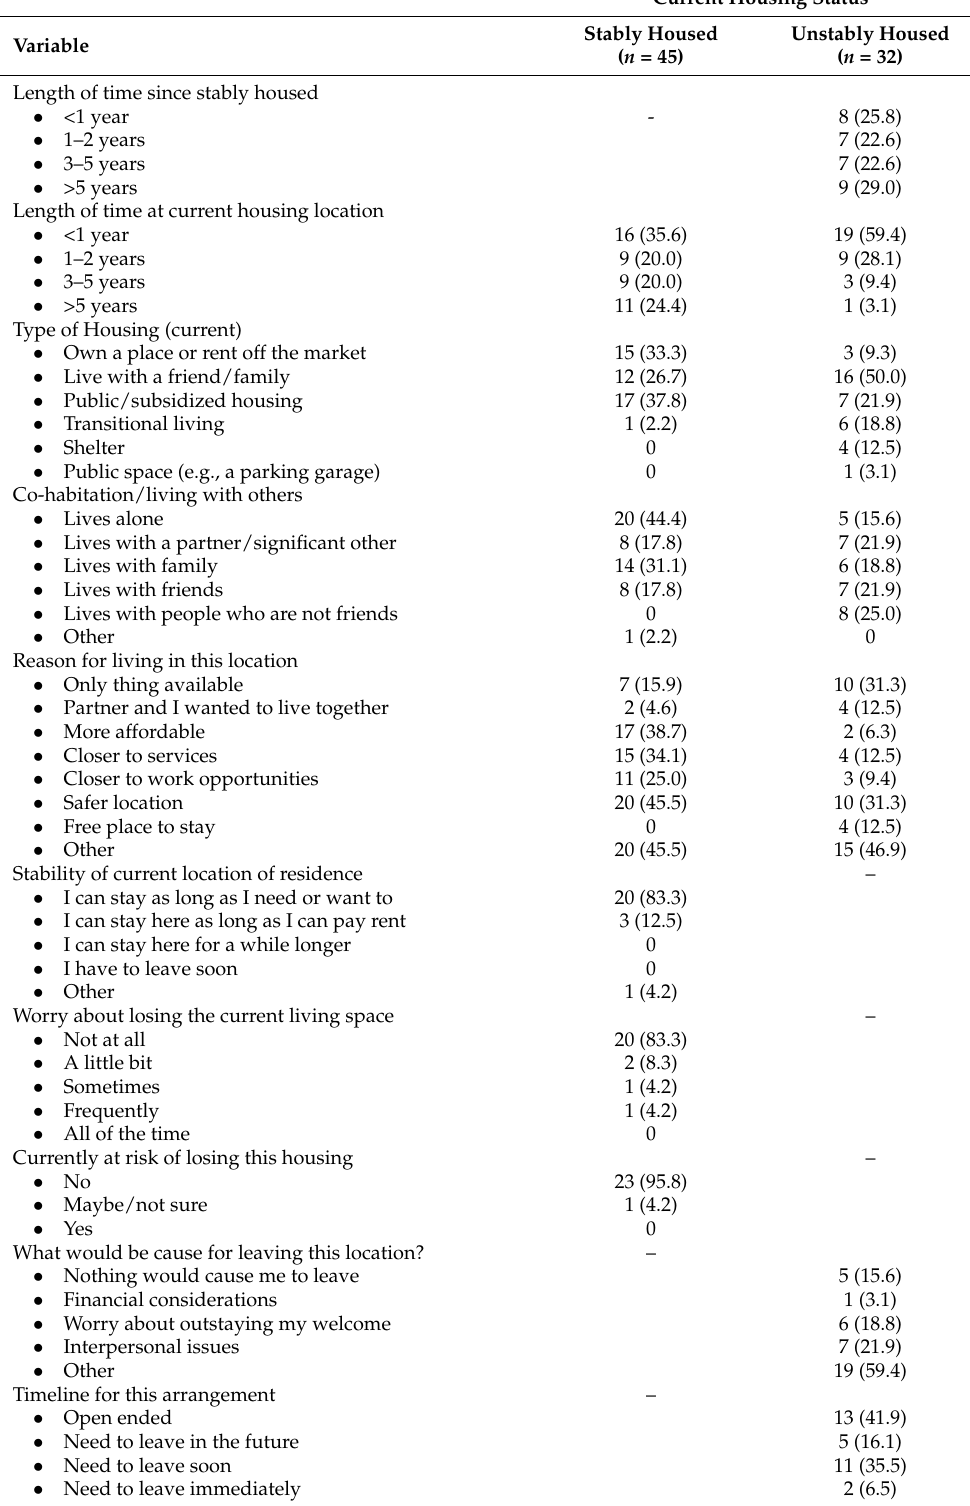
Table 2. Descriptions of housing situations for those who are stably and unstably